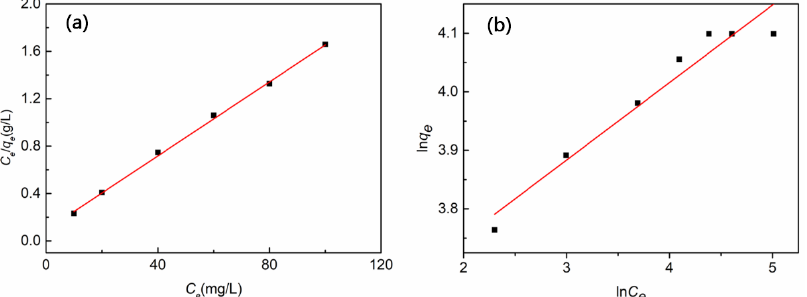
Figure 12. Fitting diagram of adsorption isotherm of Cu 2+ (100 mg/L, pH = 5) adsorbed by 5 wt%